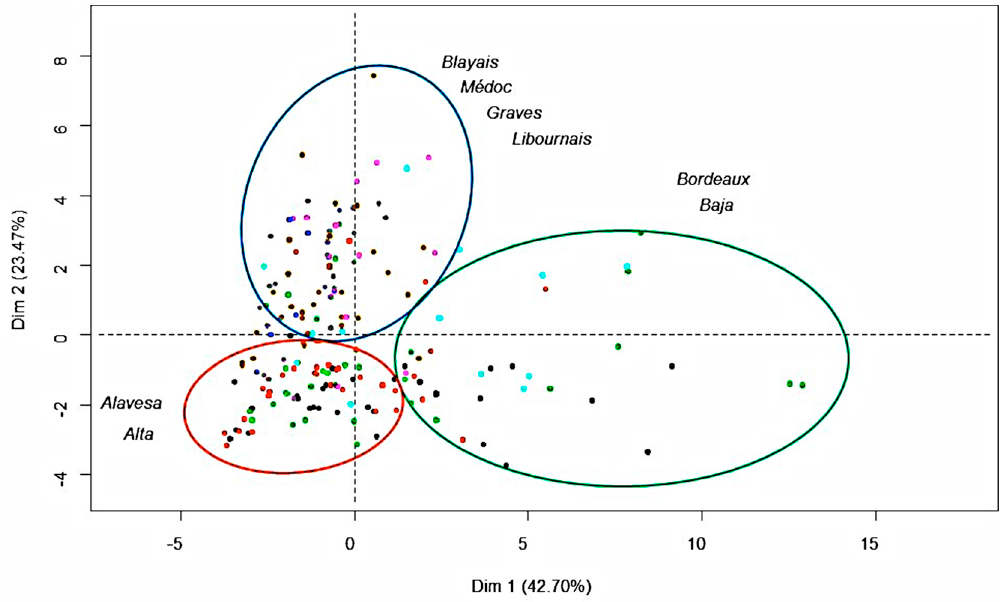
Figure 4. Distribution of the wine samples among PC1 (Dim 1) and PC2 (Dim 2).